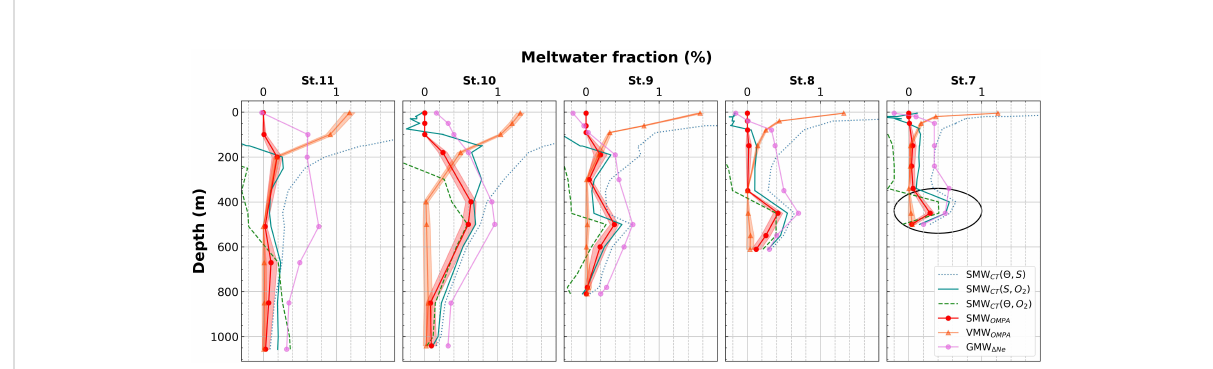
(Figure 5). One notable discrepancy is the gradual decrease in SMW fractions from near the ice shelf to the continental shelf break (0.6% to 0.2%) when employing the NG-OMPA method (SMW OMPA ). This decrease was consistent with the fact that the saturation anomalies of Ne ( D Ne), which are proportional to the meltwater fractions, decreased gradually from the ice shelf to the shelf break (Figure 2E). In contrast, the fractions obtained using the CT method did not vary remarkably, with values